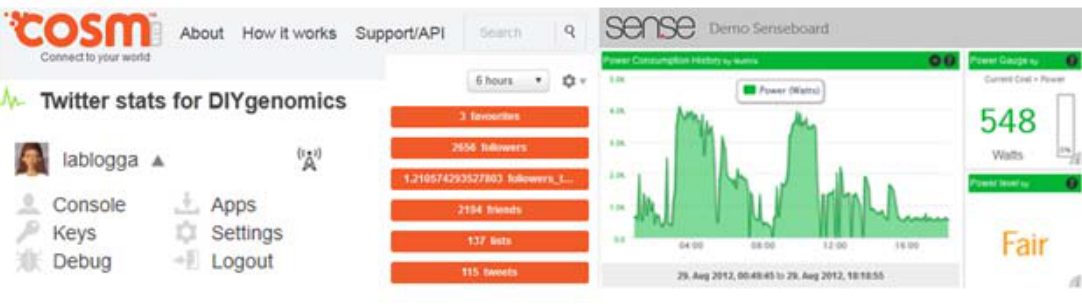
Figure 10. Examples of the Infographic Sensor Data Displays from Cosm and